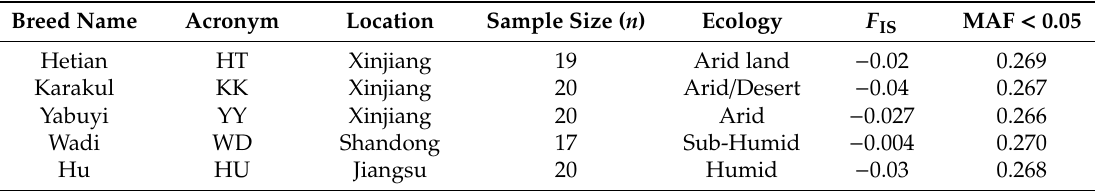
Table 2. Summary of samples, inbreeding coe ffi cients and minor allele’s frequency in five Chinese sheep